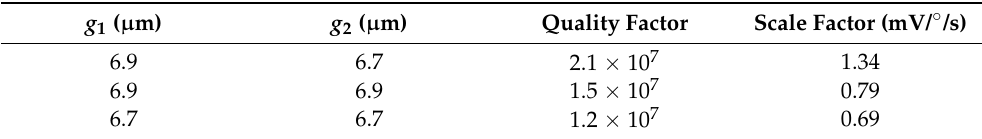
Table 1. Quality factors and scale factors of resonators with different parameters tested by the ex- periment.